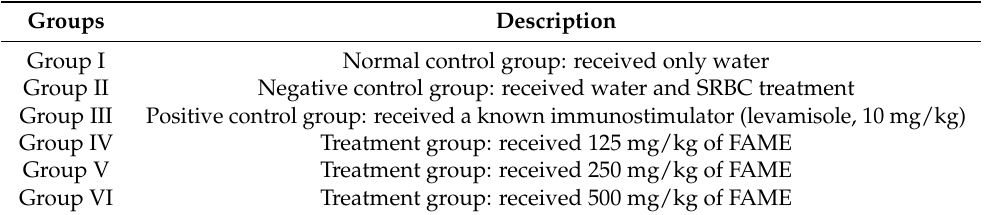
Table 1. Treatment group description.